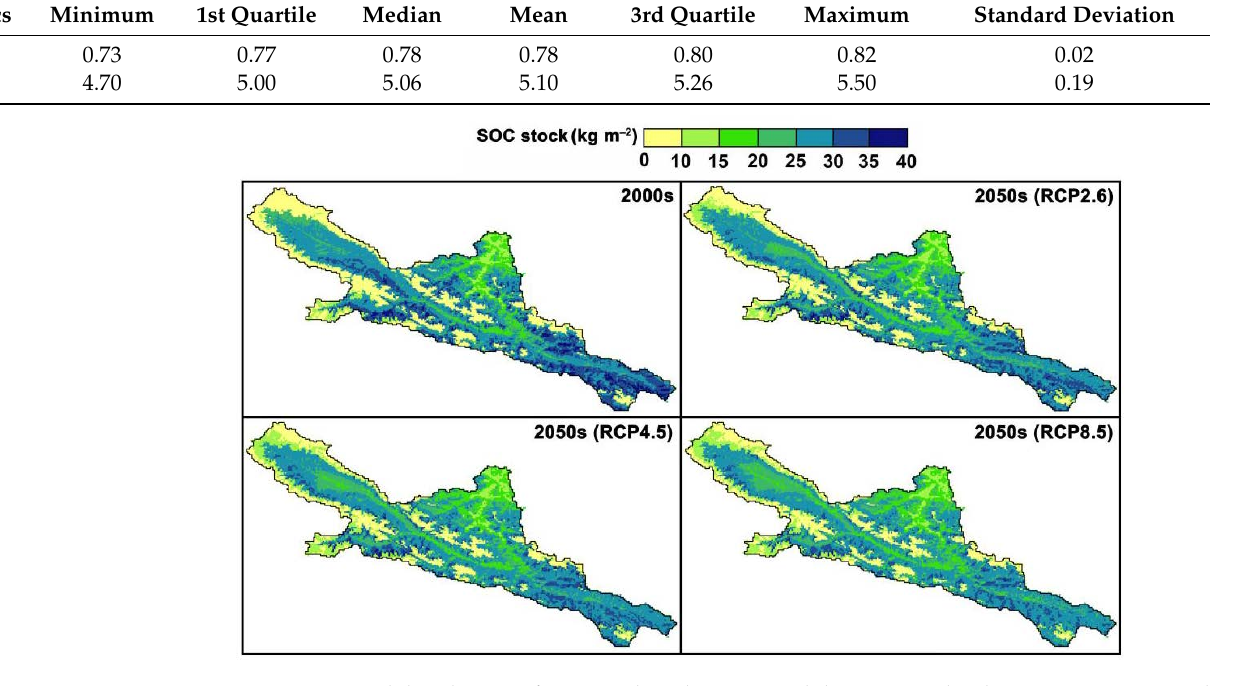
Figure 9. Spatial distribution of SOC stock in the 2000s and the 2050s under the RCP2.6, RCP4.5 and RCP8.5 scenarios, respectively.